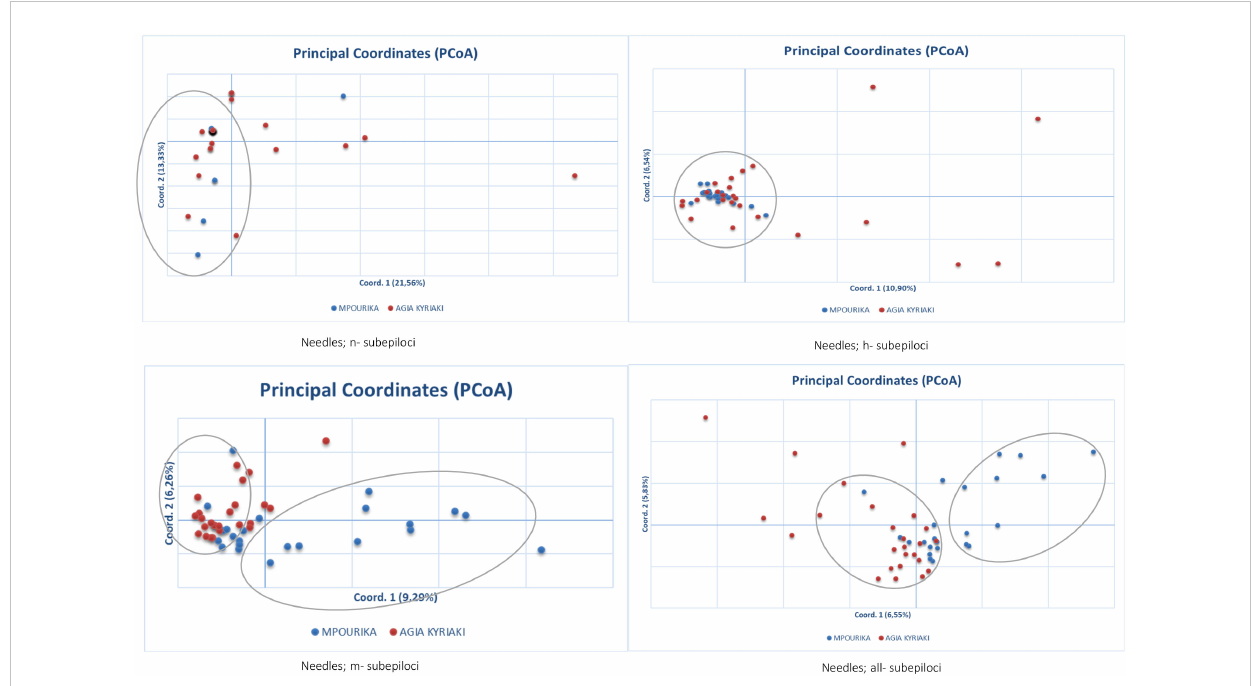
FIGURE 4 Principal coordinate analysis (PcoA) of epigenetic distances based on MSAP analysis, of needle tissue, in the exposed (Mpourika) and the control (Ag. Kyriaki)